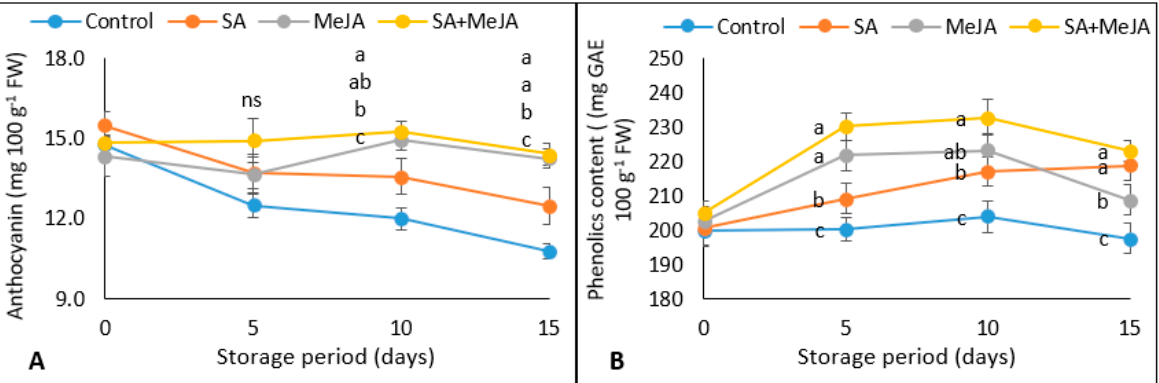
Figure 5. Effects of salicylic acid (SA), methyl jasmonate (MeJA), or their combination postharvest treatments on ( A ) anthocyanin content and ( B ) phenolic content of pomegranate arils stored at 5 °C for 15 days. The presented data are the mean of three replicates ± standard error. Different letters present significant differences between treatments at the same storage point according to the Duncan test at p < 0.05.